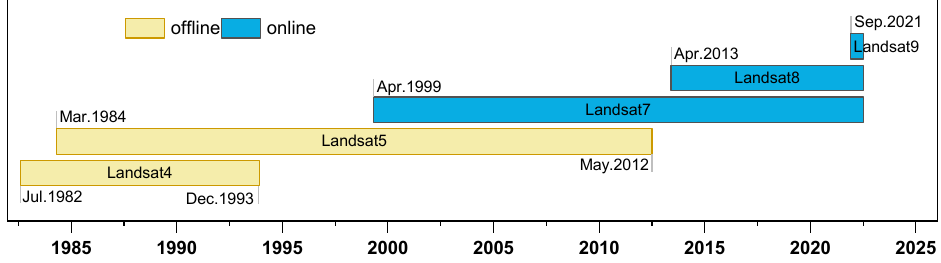
Figure 1. Availability of observation data from different Landsat satellites. The satellites marked in blue are still operational, and the ones marked in yellow are no longer available. An SLC-off failure occurred on Landsat 7 since 31 May 2003, which had a significant impact on data quality; with the launch of Landsat 9, its use in combination with Landsat 8 will increase the time resolution to a true 8-day